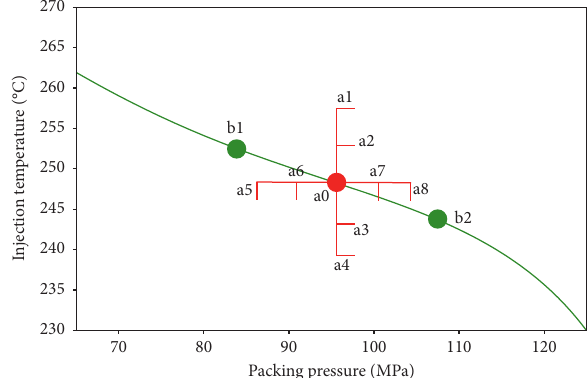
Figure 6: Verification experiments scheme: a0, b1, and b2 are process parameters on the hyperplane, while a1, a2, .... . . , a8 are process parameters not on the hyperplane.